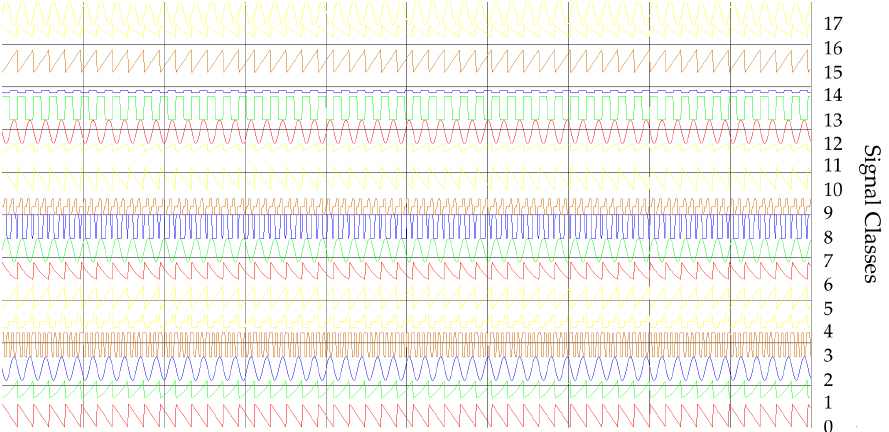
Figure 5. Illustration of training signals with inter-pulse modulation of PRI.